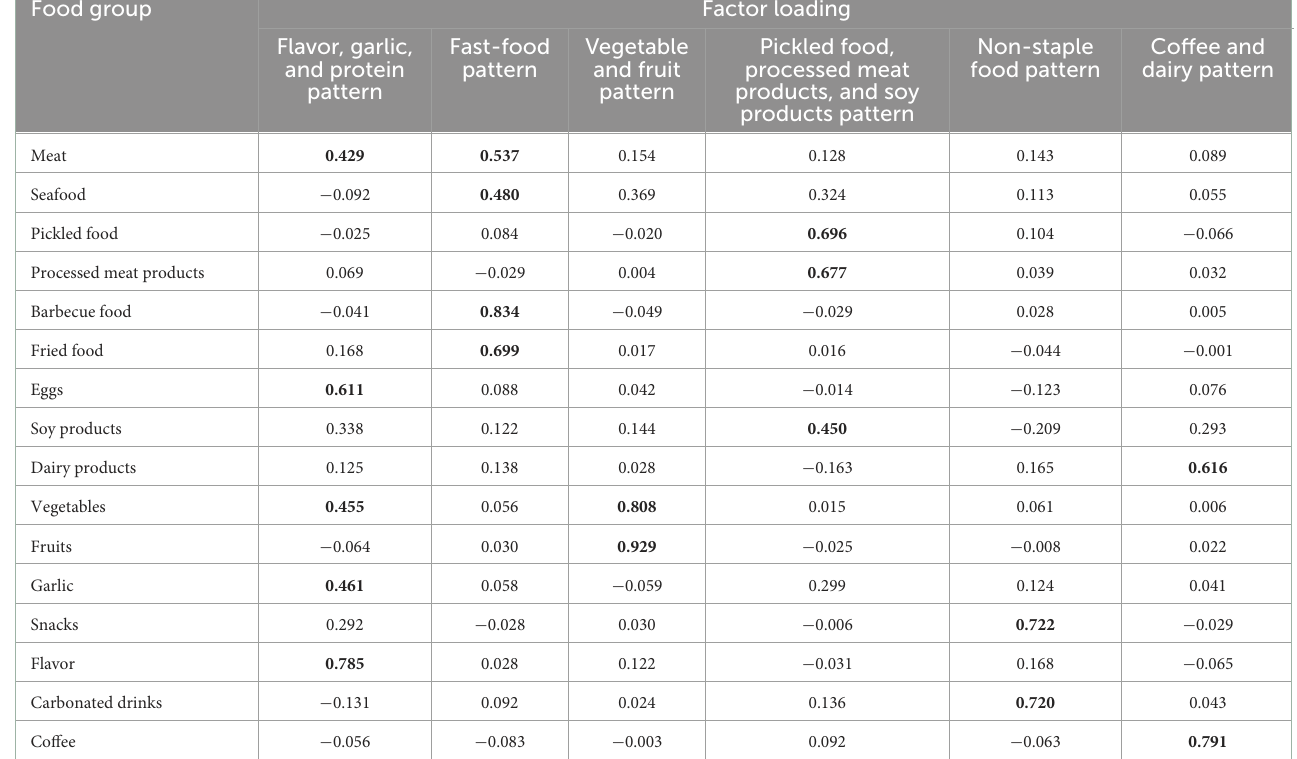
TABLE 2 Dietary pattern and factor loading. Food group Factor loading